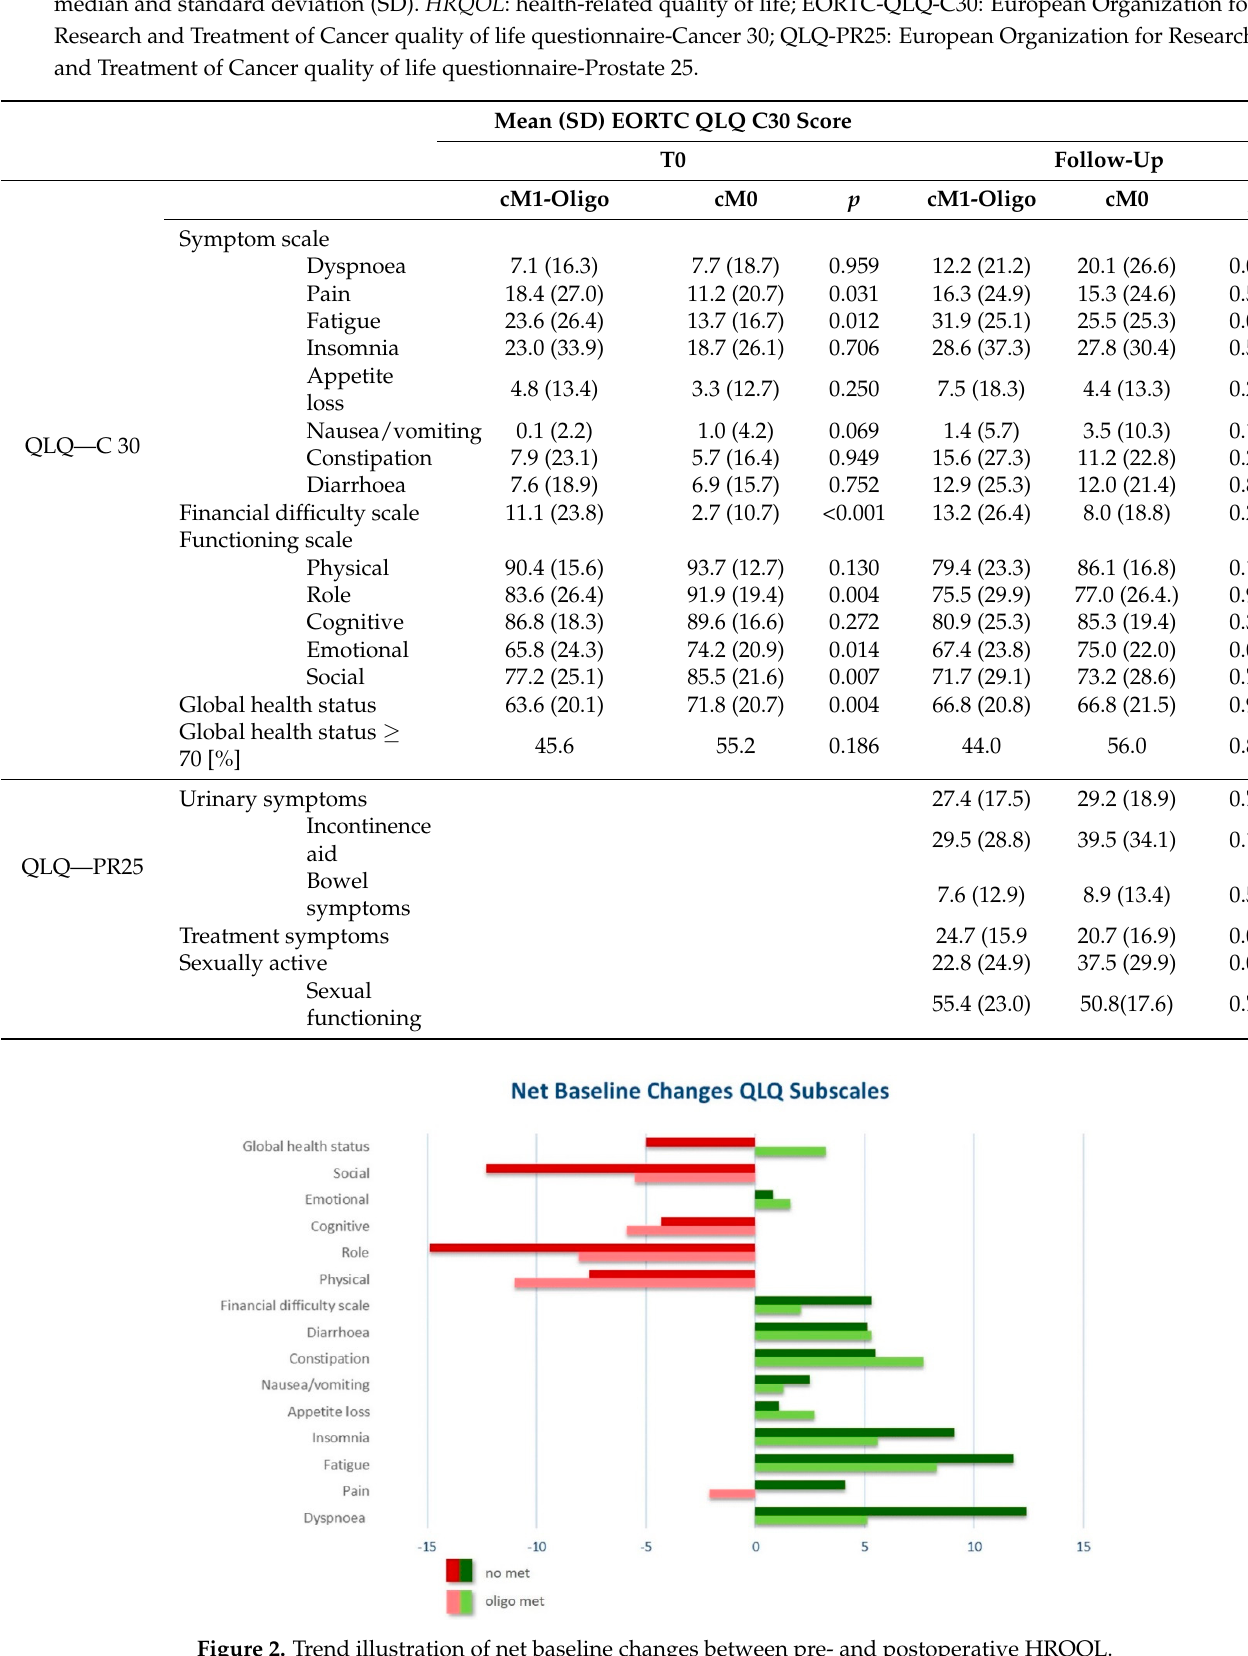
Figure 2. Trend illustration of net baseline changes between pre- and postoperative HRQOL.